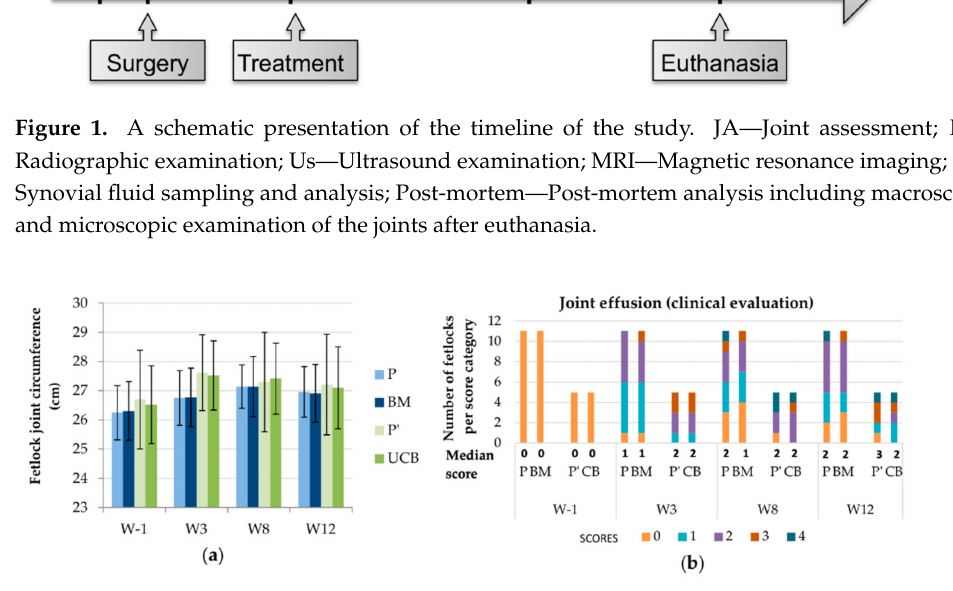
Figure 2. Evolution of two clinical parameters throughout the study period displayed per treatment group and per time point. ( a ) Mean (standard deviation) of the fetlock joint circumference. ( b ) Median scores and number of fetlocks per joint effusion score. W—Week; P—Fetlocks injected with placebo, contralateral of the fetlocks injected with bone-marrow derived mesenchymal stem cells (BM-MSCs); BM—Fetlocks injected with BM-MSCs; P’—Fetlocks injected with placebo, contralateral of the fetlocks injected with umbilical cord blood derived mesenchymal stem cells (UCB-MSCs); CB—Fetlocks injected with